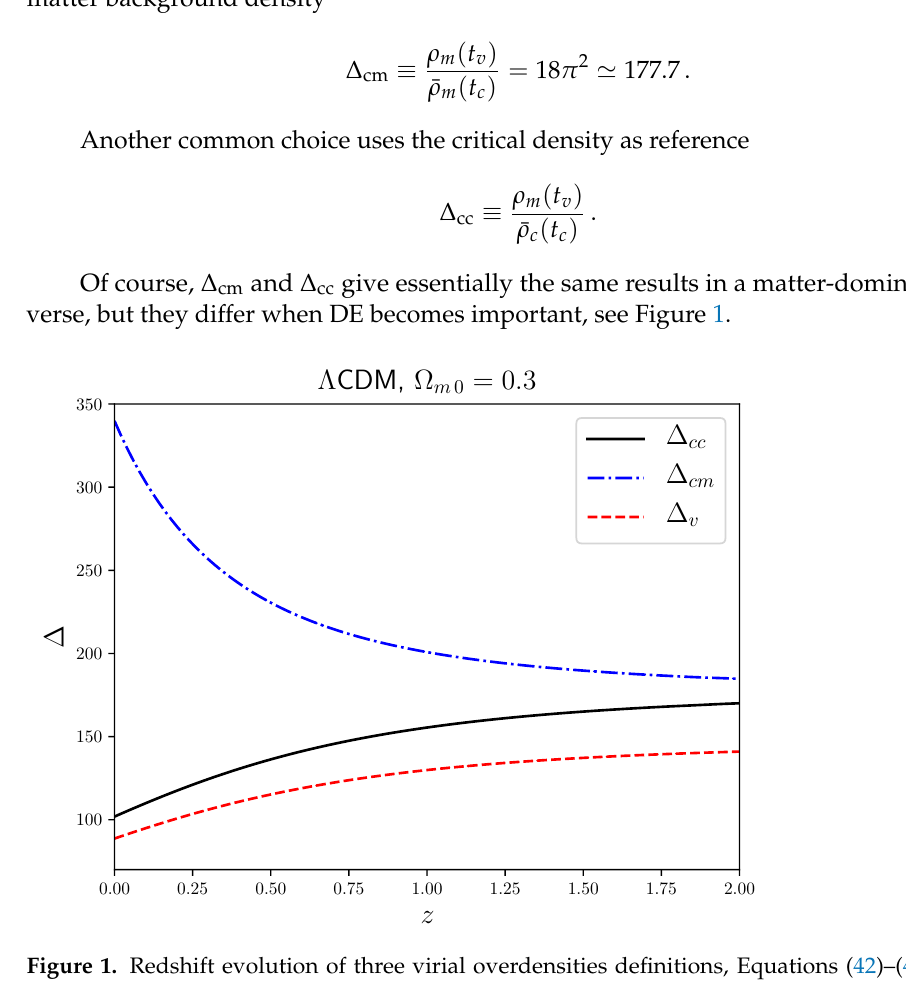
Figure 1. Redshift evolution of three virial overdensities definitions, Equations (42)–(44) for the Λ CDM model with Ω ∆ v is determined using the method summarized by m 0 = 0.3. In this plot, Equation (78), while ∆ cm and ∆ cc are determined by the proper numerical method discussed in Section